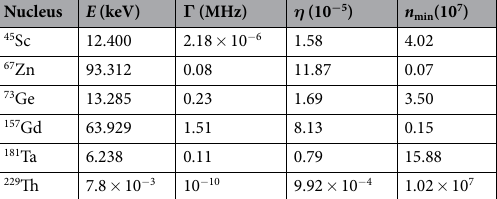
Table 1. Suitable nuclear Mössbauer transitions for the optomechanical control of x-ray absorption. The nuclear transition energies E and corresponding linewidths Γ are given in the first two columns 29, 30, 43, 44 . The Lamb-Dicke parameters η in the absence of the optical laser obtained for the parameters employed in Fig. 2 are presented in the third column. The minimum phonon number n min for resolving the first phonon line and the valid maximum phonon number n max = 100 n min are calculated by using η . ≤ < n 0 1 1